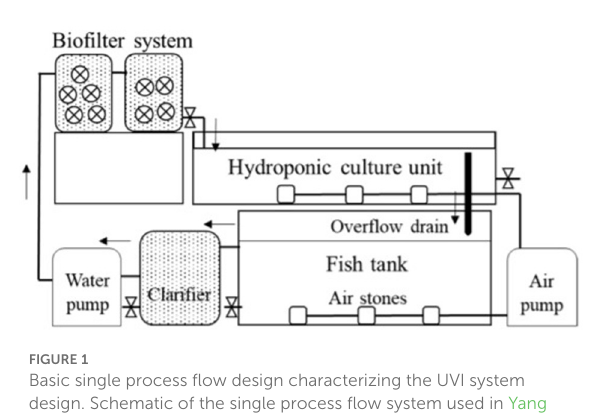
FIGURE1 Basic single process flow design characterizing the UVI system design. Schematic of the single process flow system used in Yang and Kim (2020) where research was conducted to determine the effect of system retention time on water quality and fish and plant growth in coupled aquaponics. With a single loop design, only one water flow could be used in the system, preventing optimization of individual